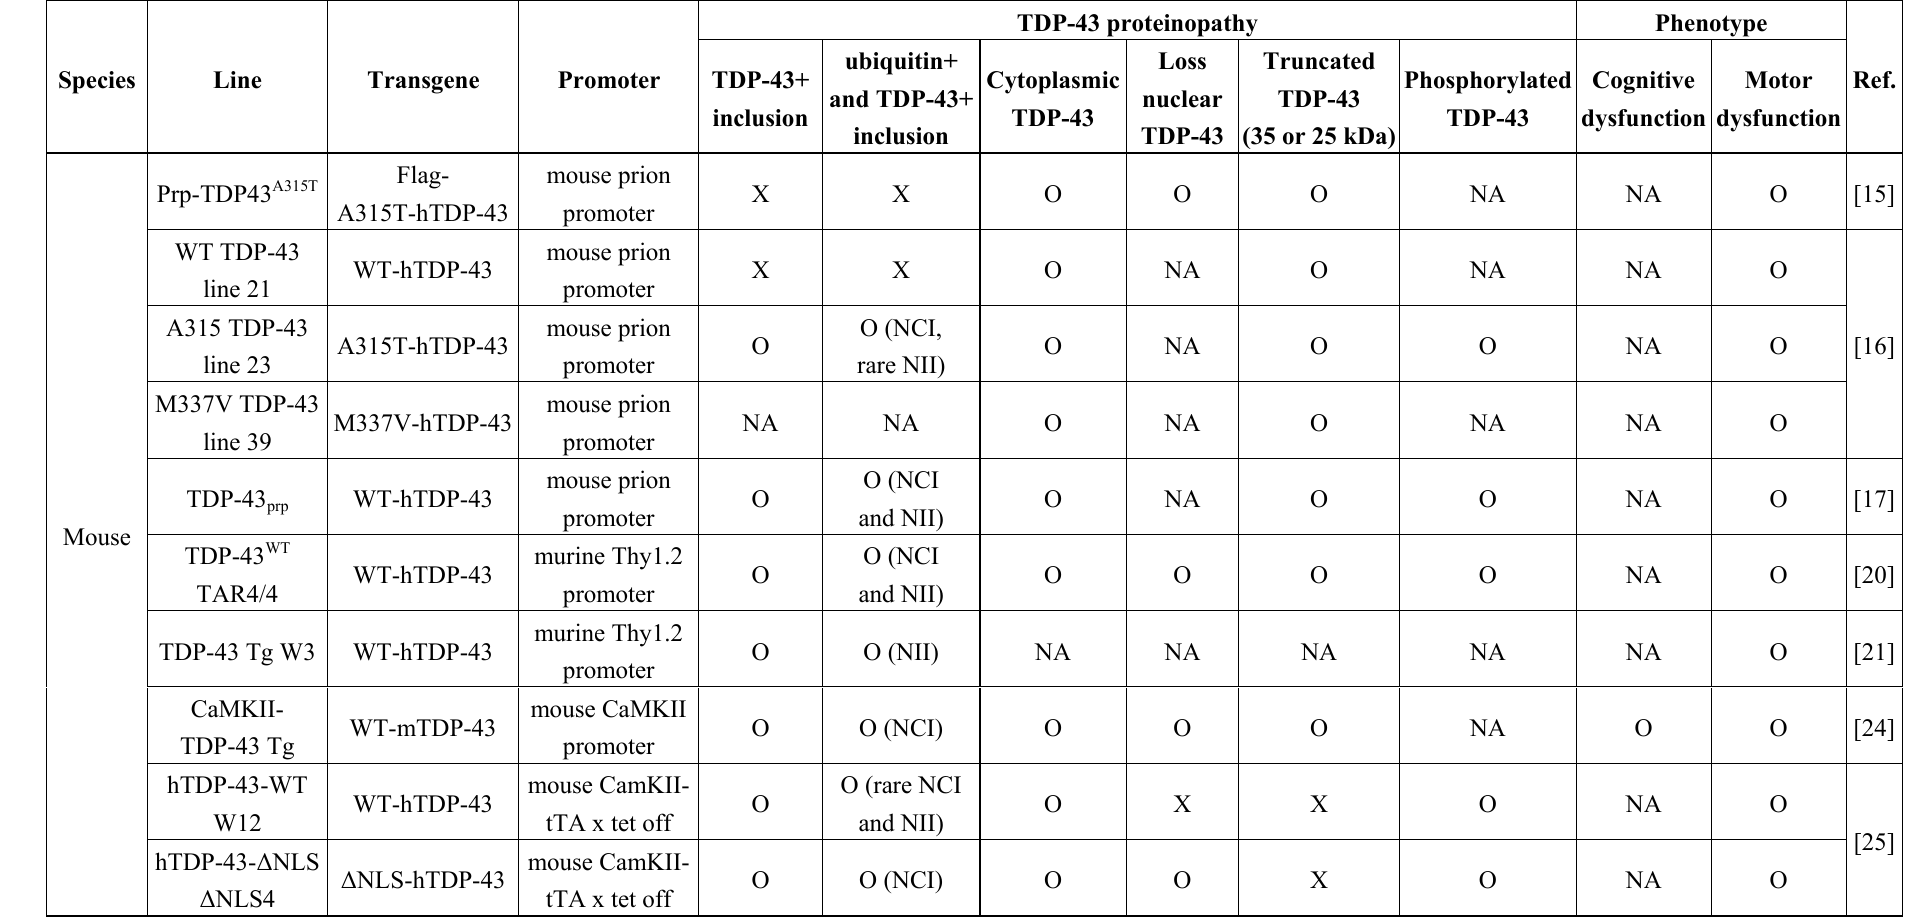
Table 1. Mammalian models: wild-type or mutant TDP-43 expression by transgenic animals (NA: non-analysis).